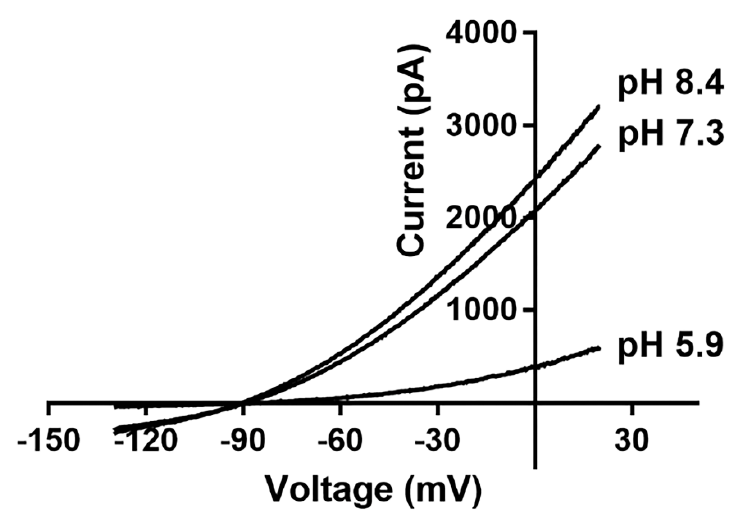
Figure 2. Representative illustration of the current − voltage (I − V) relationship for TASK channels under different extracellular pH conditions. TASK channels are sensitive to changes in extracellular pH; they are significantly inhibited by acids and are weakly activated by alkalis.